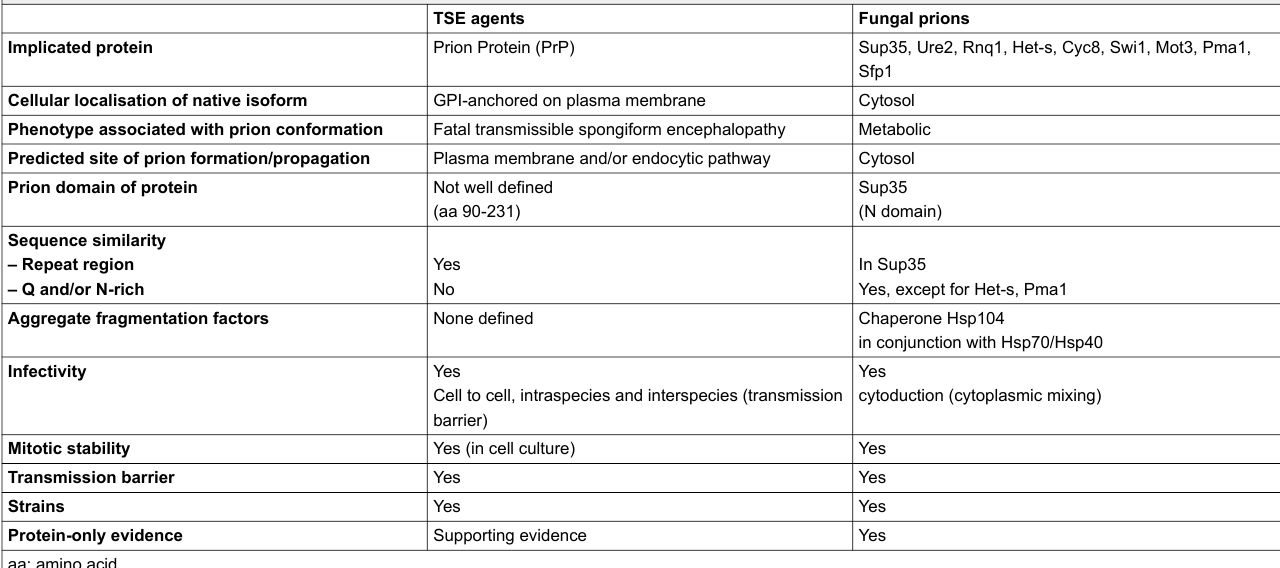
Table 2: Comparison of the main characteristics of mammalian and fungal